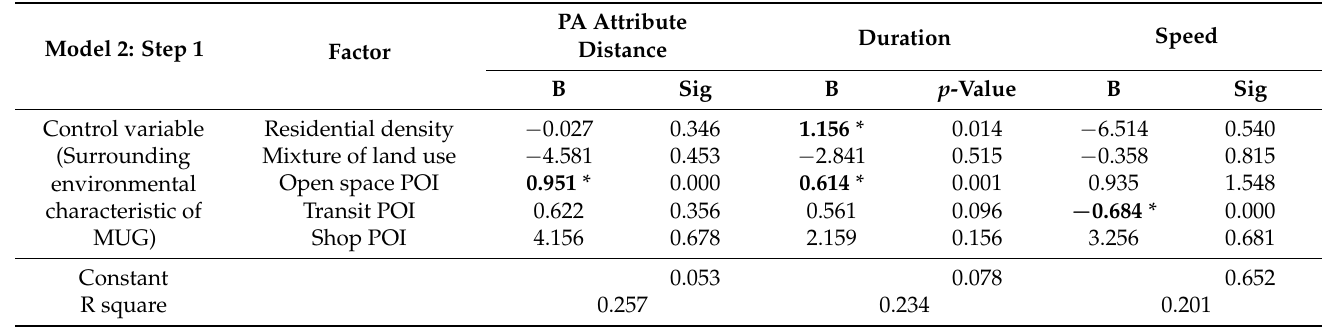
Table 7. Linear regression model of PA attributes: Step 1.